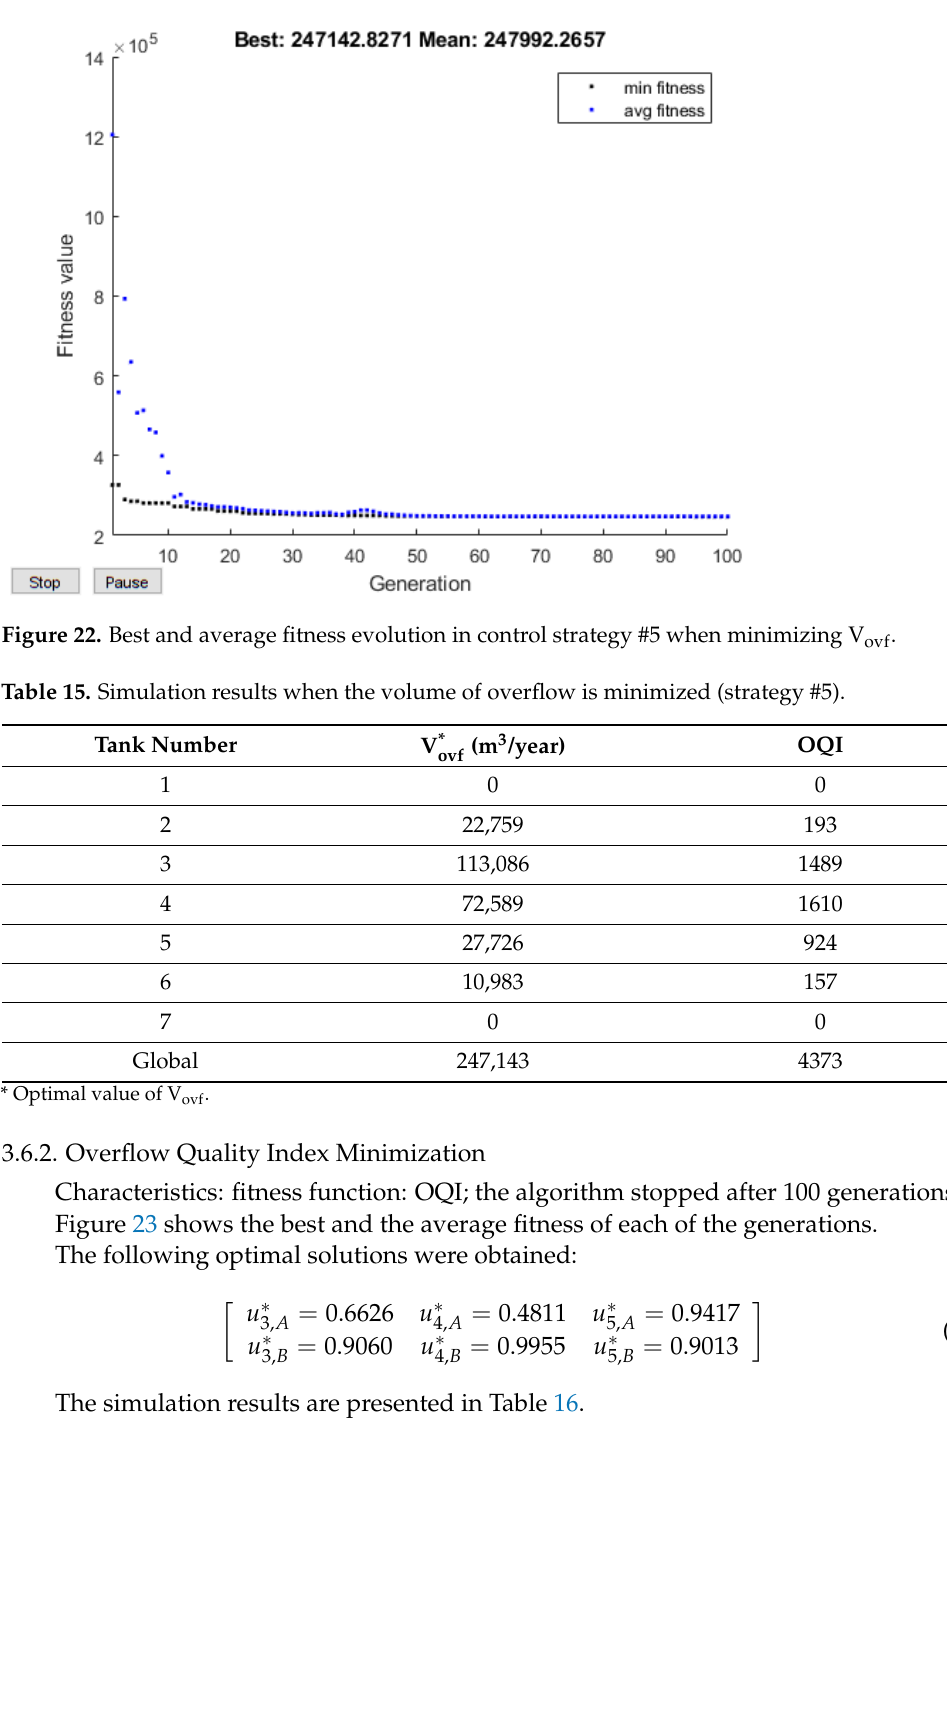
Figure 21. Strategy #5 chromosomal structure. Volume of Overflow Minimization